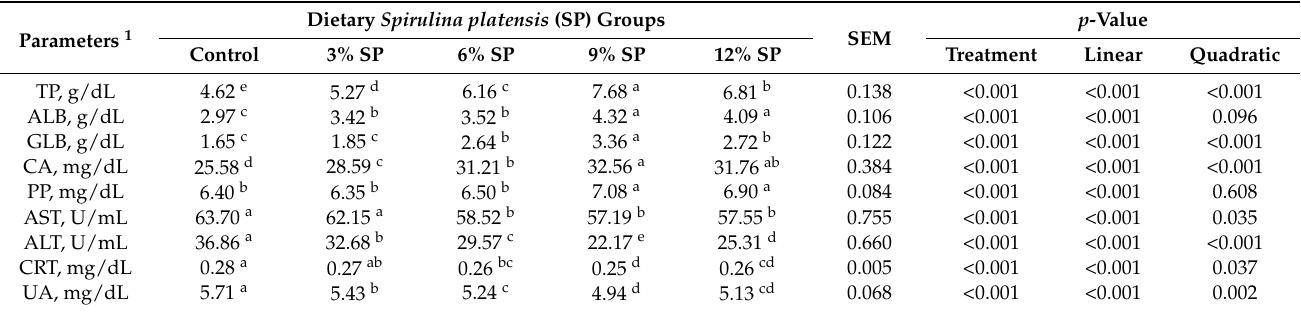
Table 5. Effect of dietary Spirulina platensis on the blood biochemicals of laying